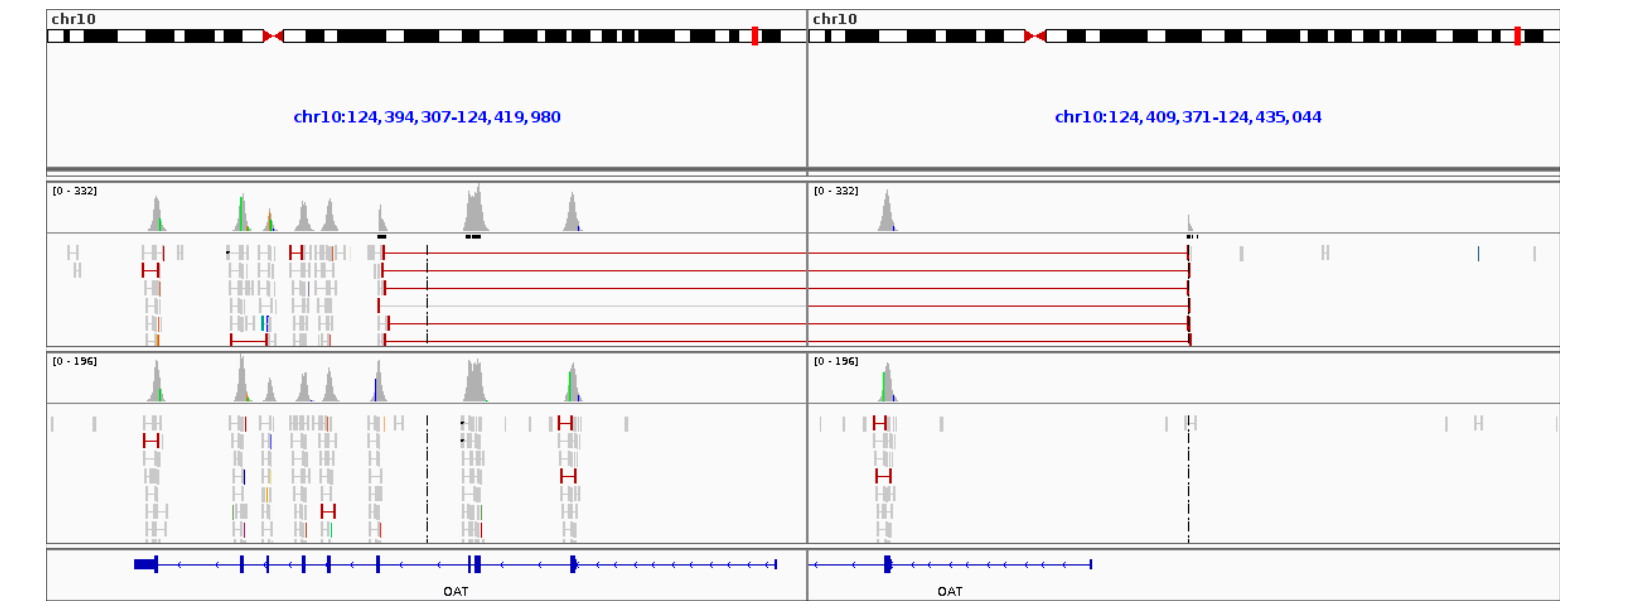
Figure 10. Sequencing results from the gyrate atrophy patient aligned to the reference genome. The top collection of sequence reads are from the affected GA patient and the bottom section of reads are from an unaffected patient sequenced in parallel. Split reads (red) from the affected patient can be seen to be spanning a 16.6 kb region of the OAT gene as viewed in IGV (Integrative Genomics Viewer).